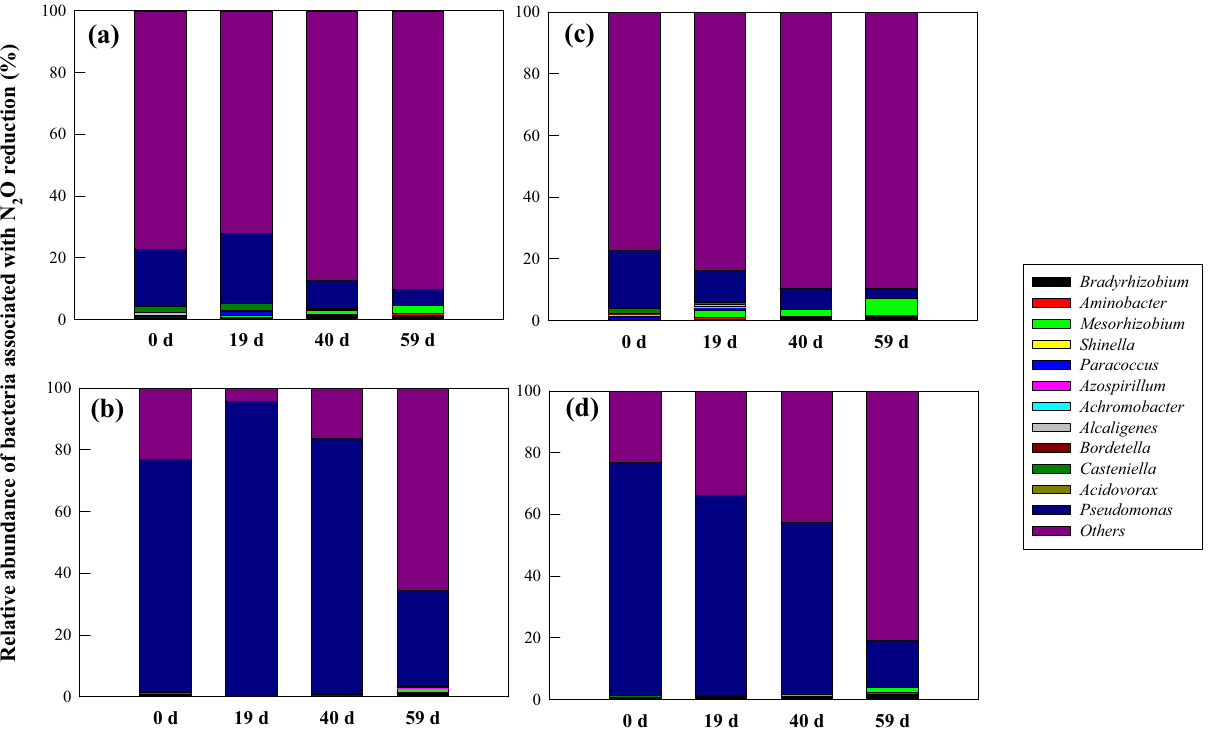
Figure 6. Dynamics of the bacterial genera associated with N 2 O reduction during the rhizoremediation of diesel-contaminated soil. ( a ) Soil planted with tall fescue. ( b ) Soil planted with tall fescue with the addition of strain TF716. ( c ) Soil planted with maize. ( d ) Soil planted with maize with the addition of strain